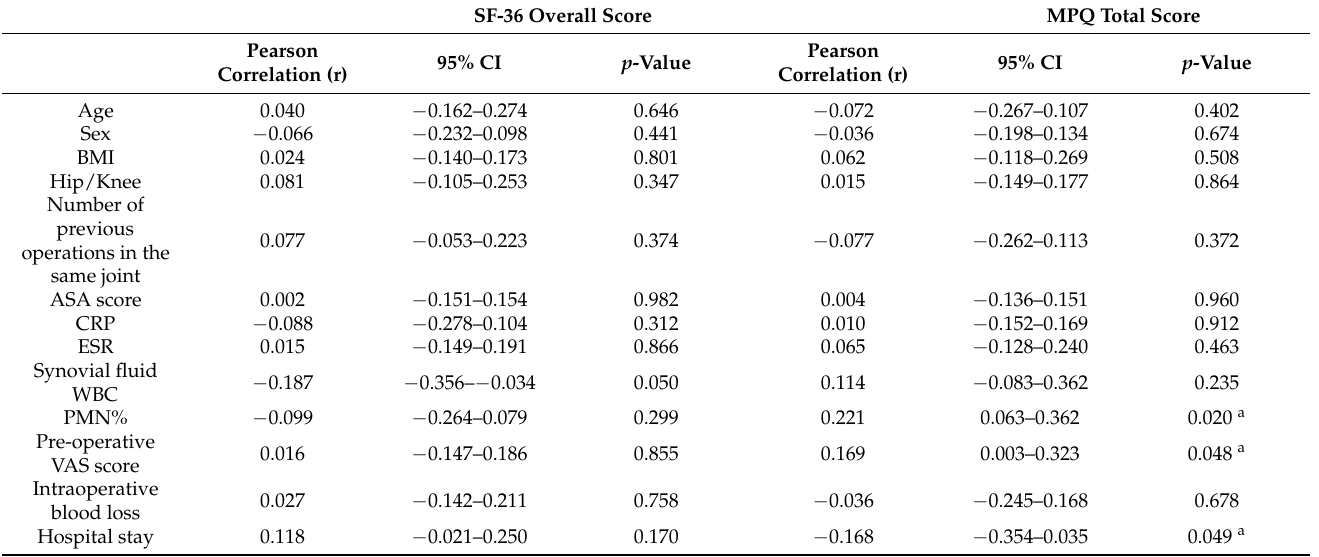
Table 4. Potential risk factors for QOL and pain after revision surgery for